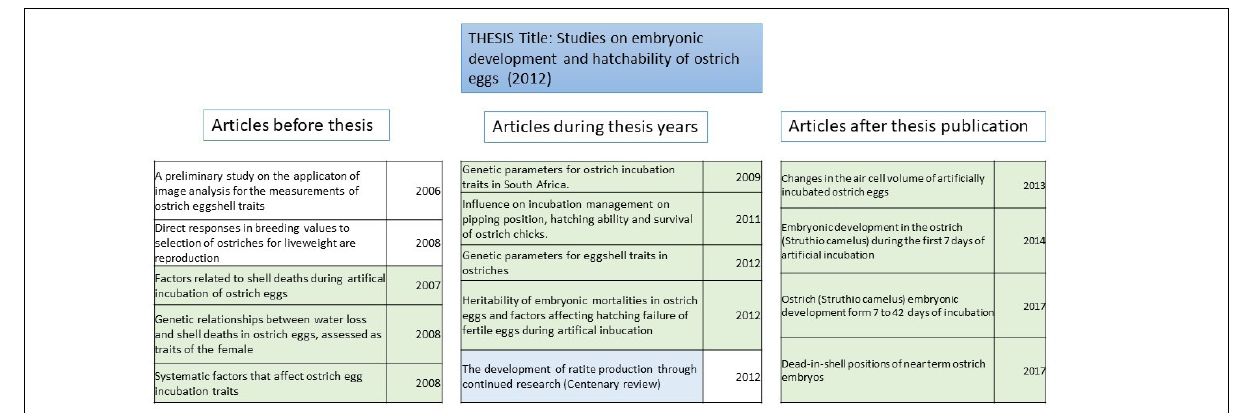
Figure 2: Illustrative example 1 of study and publication trajectory.